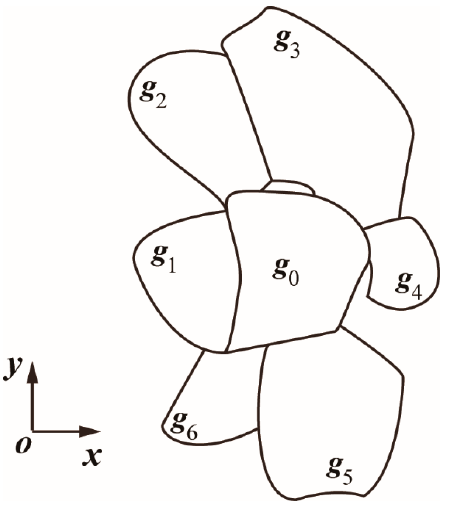
Figure 2. Two-dimensional projections of the contour structure length of the grain boundary interface layer in plane X-Y.